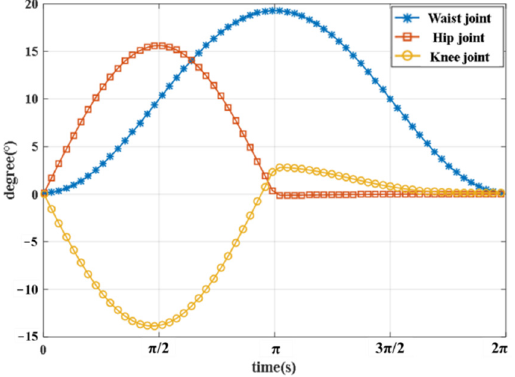
Figure 7. Leg joint angle position diagram.